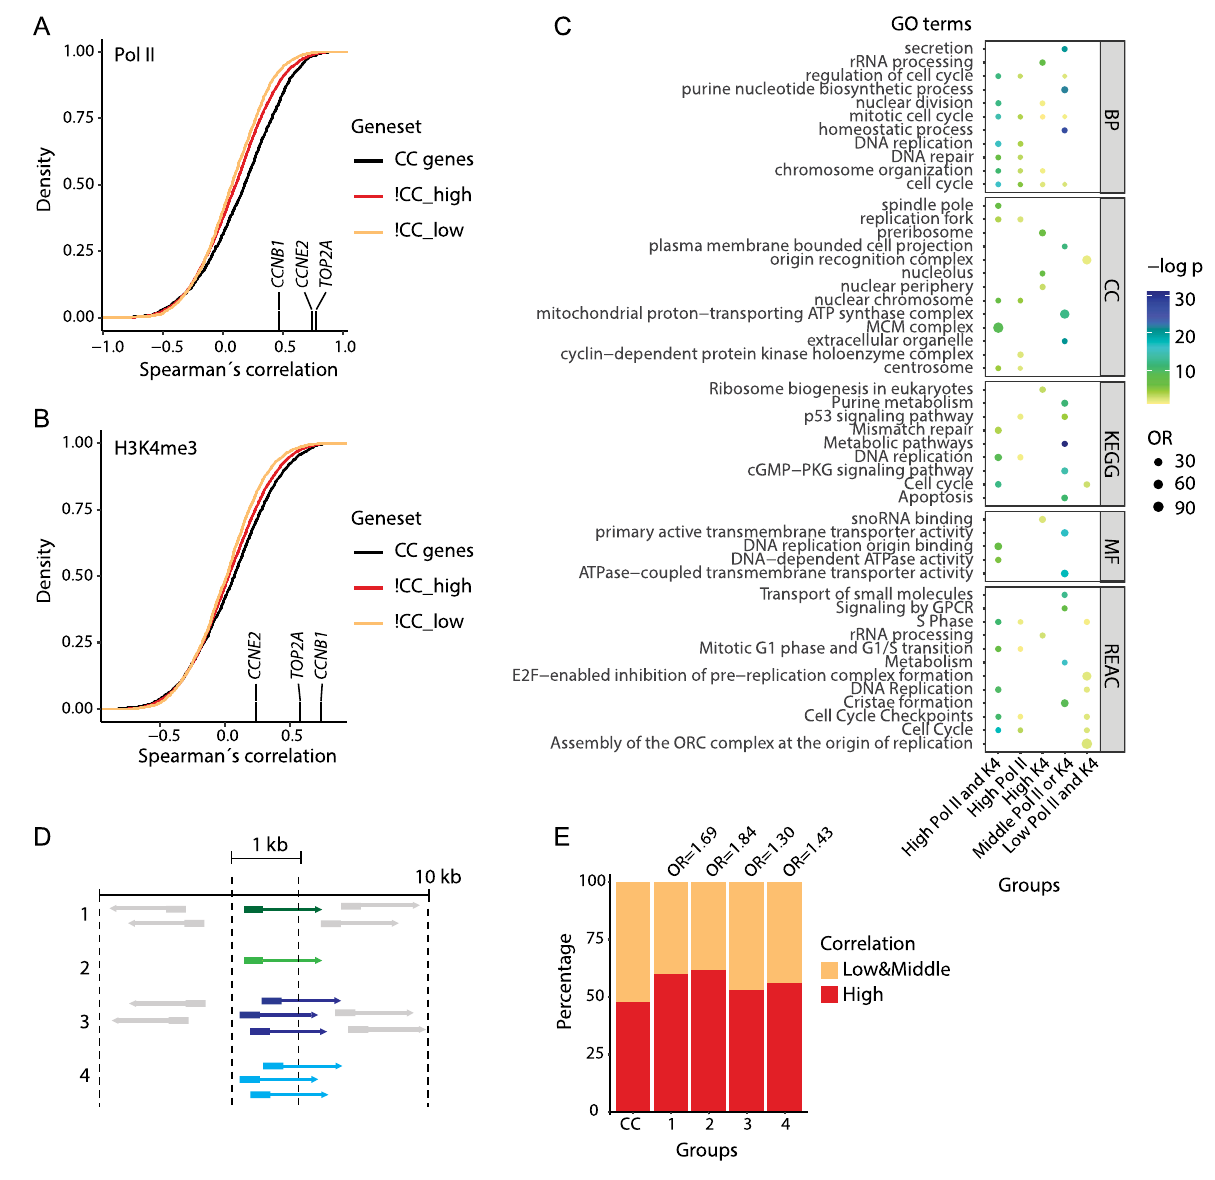
Figure 3. A set of cell cycle genes correlate with Pol II and H3K4me3 signals. ( A , B ) Cumulative distributions of Spearman’s correlation between RNA-seq expression and ChIP-seq signal through the cell cycle for the cell cycle (CC) genes, and other highly (!CC_high) and lowly (!CC_low) expressed genes. Marked on the x axis are the correlation values for CCNB1 , CCNE2 , and TOP2A . (A; Pol II) All three gene sets had a significant ( p -value < 2.2e−16) positive correlation for RNA-seq against Pol II ChIP-seq. CC genes showed significantly higher correlation than !CC_high ( p = 1.49e−11) and !CC_low ( p -value < 2.2e−16). (B; H3K4me3) CC genes and !CC_high had a significant positive correlation for RNA-seq against H3K4me3 ChIP-seq with p -values of 3.83e−15 and < 2.2e−16, respectively. P -value for the !CC_low gene set was not significant ( p = 0.2287). CC genes showed significantly higher correlation than !CC_high ( p = 0.0003859) and !CC_low ( p = 1.002e−08). Significant differences were determined by Student’s t -test (unpaired, two-tailed) assuming unequal variances. ( C ) GO analysis for cell cycle genes. The results show GO biological process (BP), cellular component (CC), molecular functions (MF) terms, and KEGG and REACTOME pathways significantly enriched ( p -values < 0.05) for cell cycle genes divided in five groups (Figure S11). ( D ) Cell cycle genes are divided into four groups based on the arrangement of TSSs and other nearby genes. Genes in group 1 (n = 127) have one single TSS and a TSS from at least one other gene within 10 kb. Genes in group 2 (n = 61) have one single TSS and no TSSs from other genes within 10 kb. Genes in group 3 (n = 356) have multiple TSSs all within 1 kb and a TSS from at least one other gene within 10 kb. Genes in group 4 (n = 152) have multiple TSSs all within 1 kb and no TSSs from other genes within 10 kb. ( E ) Odds ratios from Fisher’s exact tests comparing the fraction of highly correlated genes in the groups (d) with all cell cycle genes with Pol II signals (n = 1735). Group 1 p = 0.006, group 2 p = 0.026, group 3 p = 0.028, and group 4 p =